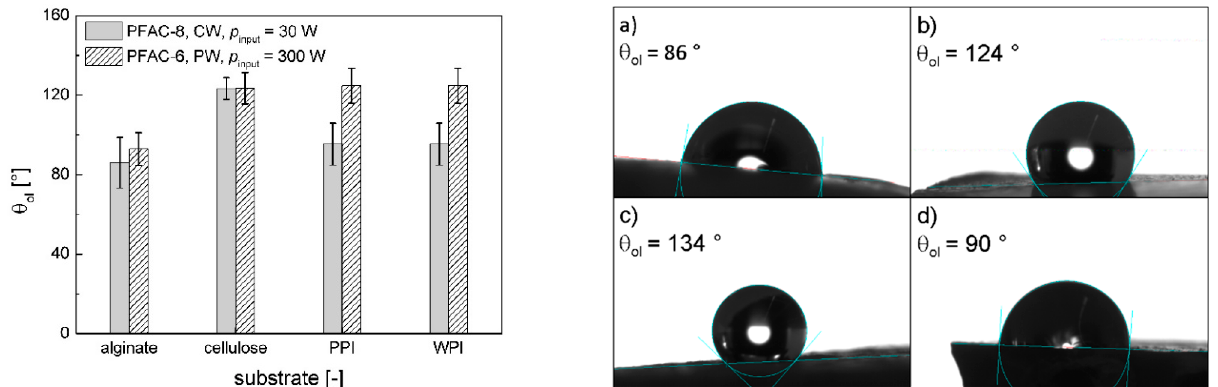
Figure 3. θ ol for different substrate/coating combinations. Values in the overview ( left ) represent the average at different process times under a given process condition (as indicated in the legend); error bars represent the standard deviation ( n = 6). Raw data ( right ) represent exemplary process settings: ( a ) alginate, t = 5 min, PFAC-8, CW, p input = 30 W, ( b ) cellulose, t = 10 min, PFAC-6, PW, p input = 300 W, ( c ) PPI, t = 5 min, PFAC-6, PW, p input = 300 W, ( d ) PPI, t = 5 min, PFAC-8, CW, p input = 30 W.